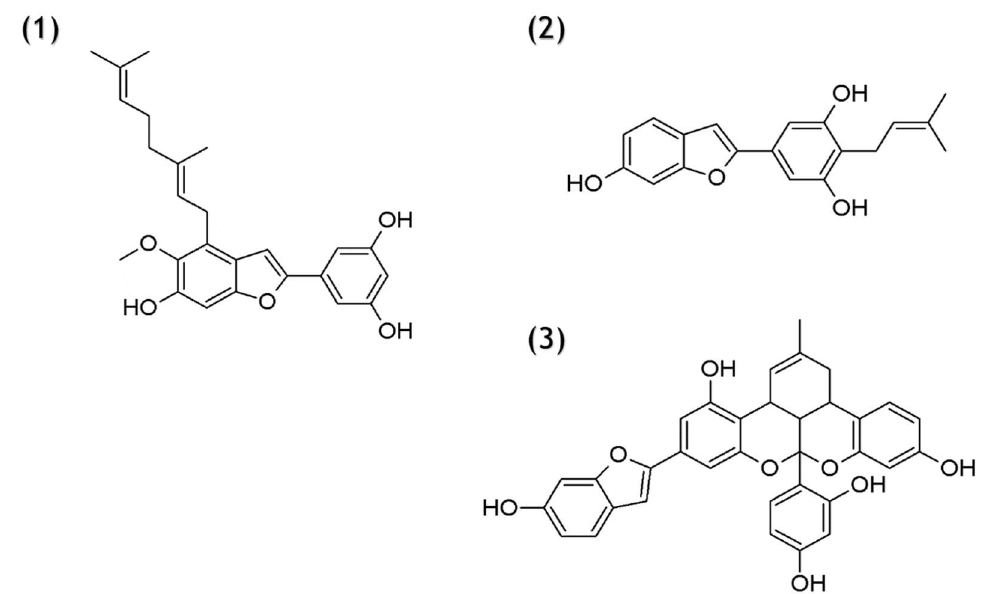
Figure 1. Structure of the tested compounds mulberrofuran Y ( 1 ), moracin C ( 2 ), and mulberrofuran G ( 3 ). G ( 3